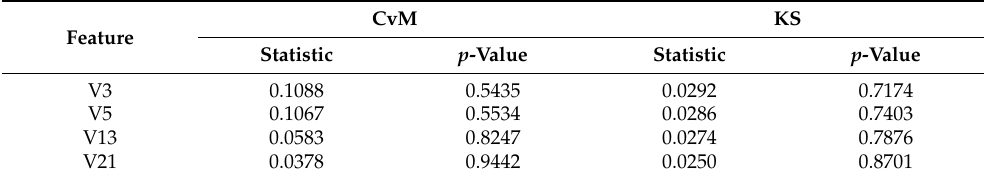
Figure 7. Empirical densities, empirical cdfs, P-P plots and Q-Q plots of the fitted MPoF distribution to the V3, V5, V13 and V21 sets. Table 8. Kolmogorov–Smirnov and Cramér–von Mises tests for the MPoF